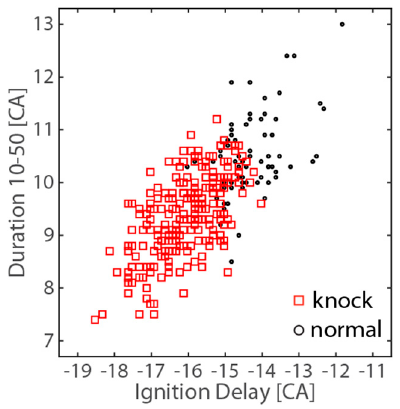
Figure 8. Duration 10–50 and ignition delay of knock and normal cycles.